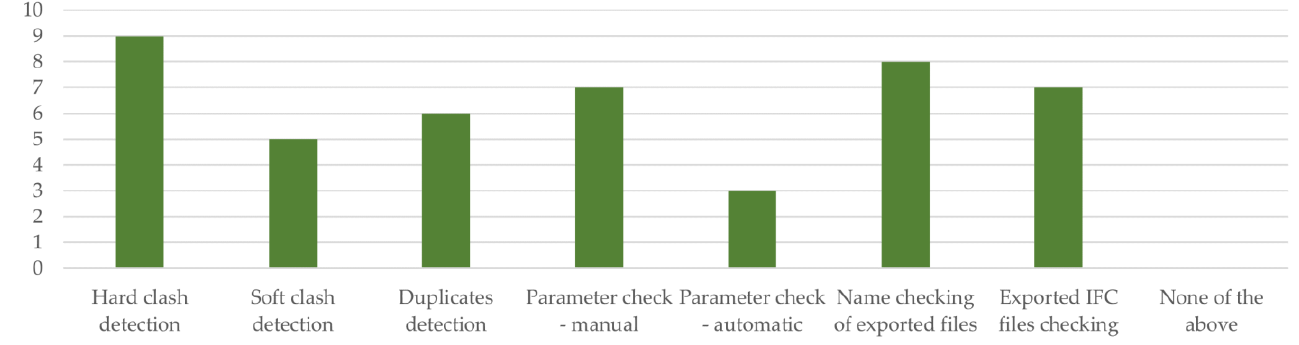
Figure 9. Responses to the question: “Which of the following tasks have been done by your team in the project?—part Checking processes”.